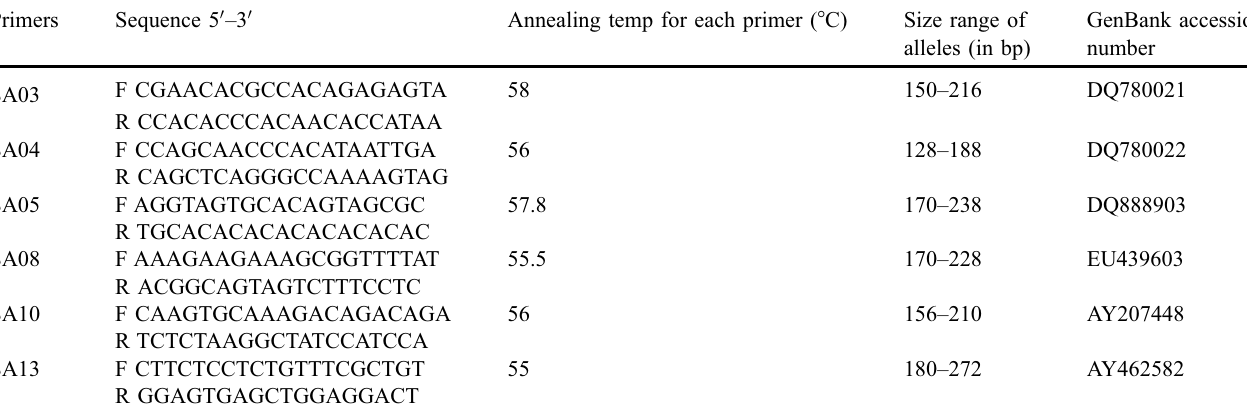
Table 1. Sequences, annealing temperature and size of alleles of ampli fi ed microsatellite primers in Sperata aor . Primers